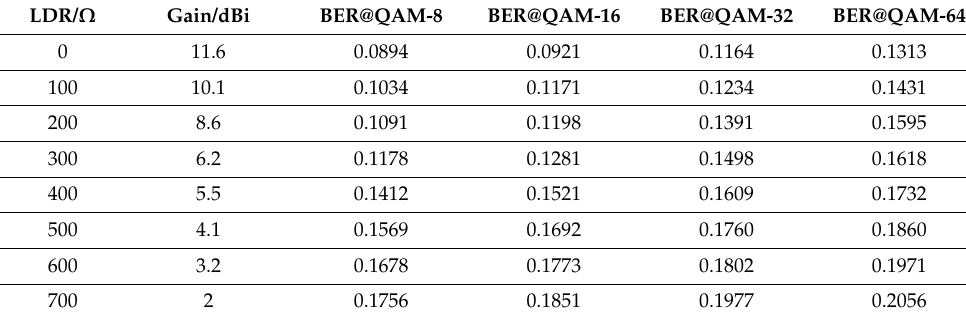
Table 2. BER evaluation at different LDR resistance values.